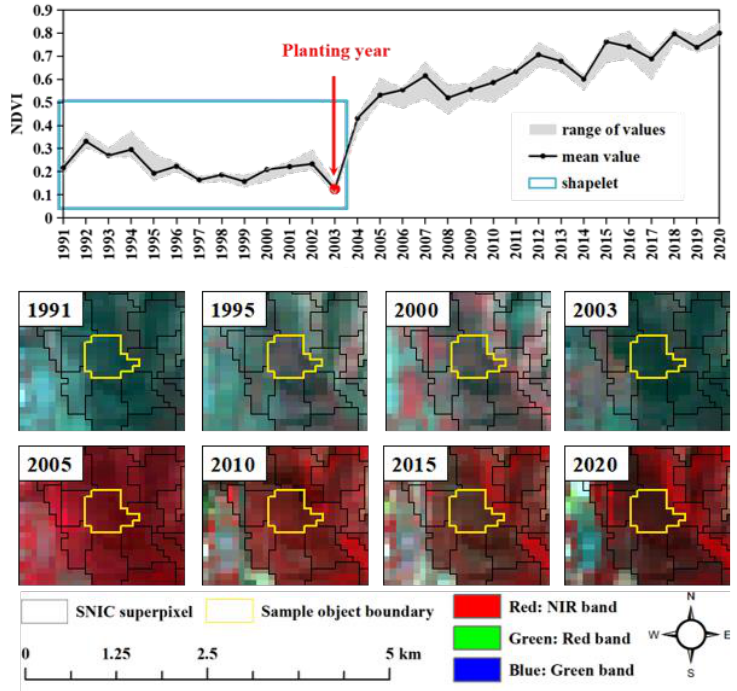
Figure 7. NDVI time-series (top) and Landsat imagery cutouts (bottom) of a planted forest sample. The top part of the figure is the NDVI time series (1990–2020) of the sample; the bottom part consists of 8 Landsat composite images from different years to depict the variation in the spectral reflectance of the sample during the period of study, and the location of the sample is indicated by a yellow polygon in the center of each image. The planting year of the sample in 2003 can be inferred.